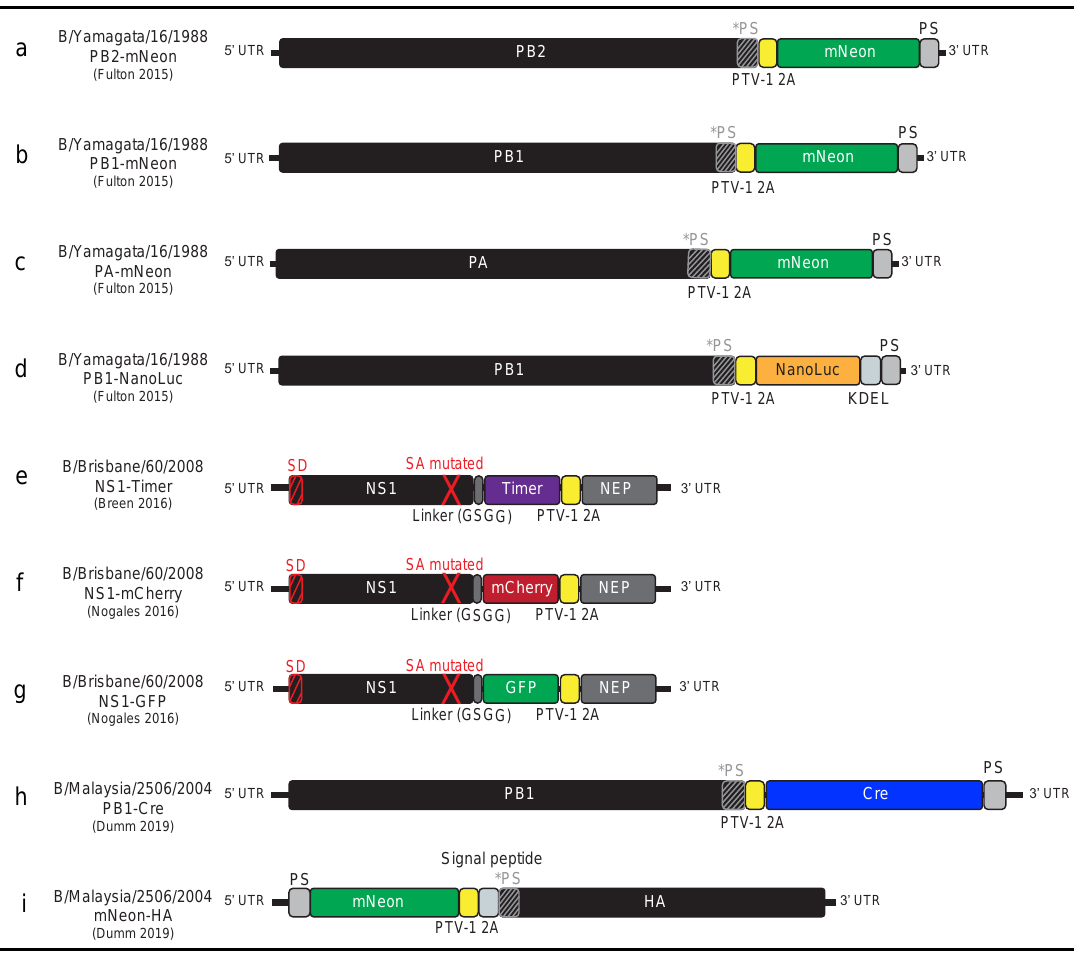
Figure 3. Designs of published influenza B virus genomic segments harboring reporter genes. ( a – c ) mNeon expressed in each of the polymerase subunit segments ( d ) NanoLuc expressed in the PB1 segment ( e – g ) Fluorescence proteins expressed in the NS1/NEP segment ( h ) Cre recombinase expressed in the PB1 segment ( i ) mNeon expressed in the HA segment. Abbreviations: PB2—polymerase